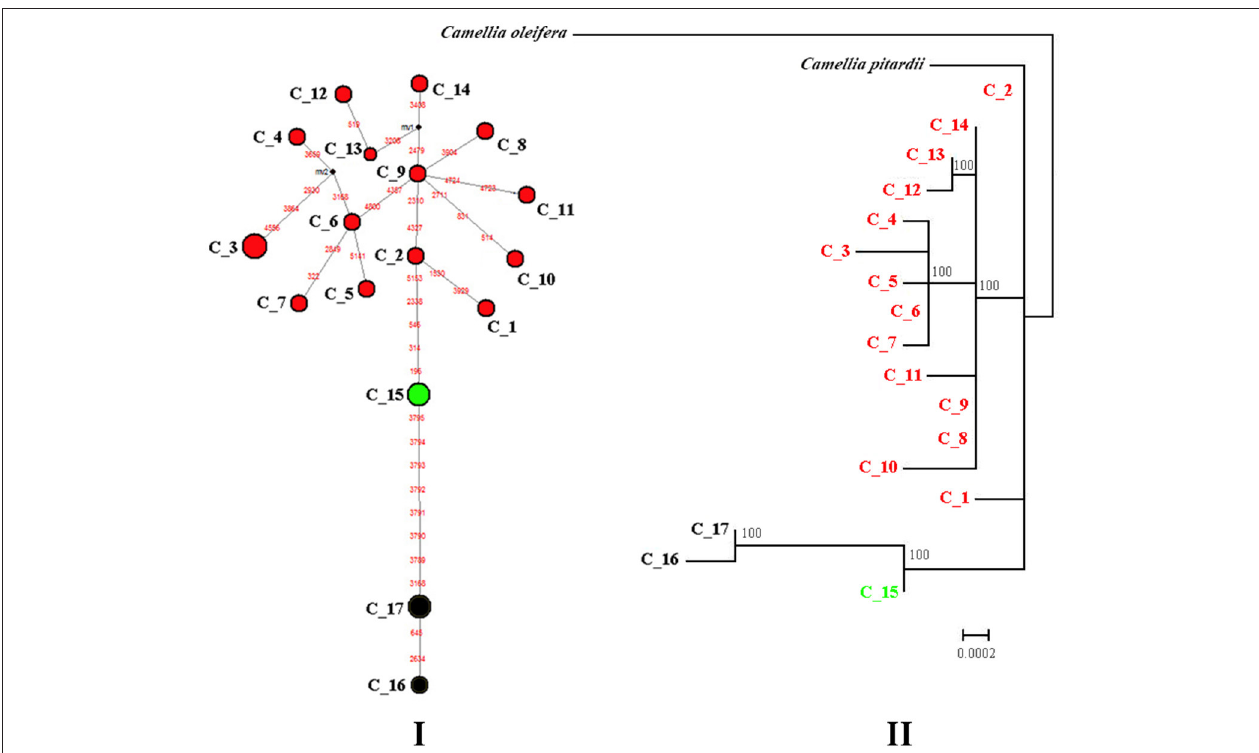
FIGURE 2 | Median-joining network (I) and Maximum Likelihood phylogenetic tree (II) showing the genetic relationships among the observed cpDNA haplotypes of C. flavida . (I) Median-joining network of 17 cpDNA haplotypes resolved in C. flavida . Each haplotype is designated by a number C_1 to C_17 (see Table S1 ). Colors denote the groups as identified by SAMOVA analyses of cpDNA marker. Circle size is proportional to haplotype frequency. Missing haplotypes are represented by black dots, and mutations are shown in red. (II) Maximum Likelihood tree. Numbers at nodes represent the result of the ML bootstrap analysis. Nodes without numbers correspond to supports weaker than 70%